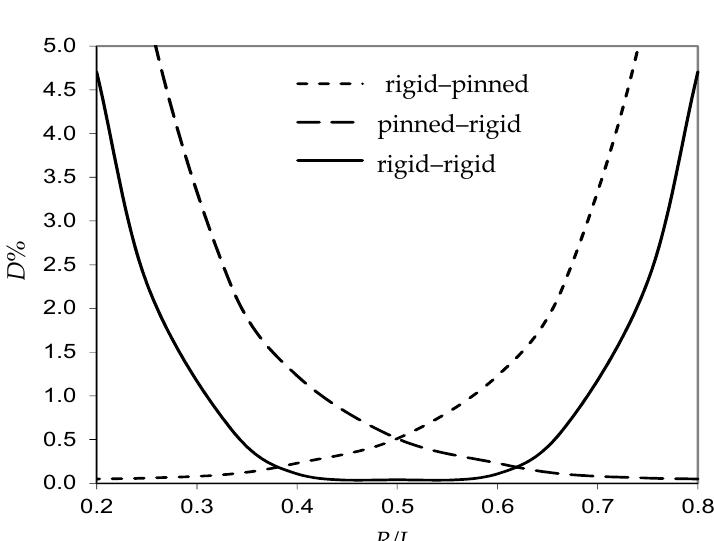
Figure 6. Variation of maximum deviation of ω 2 / ω o2 from linear dependency in the range of 0 ≤ u ≤ u cr vs. the R / L ratio.